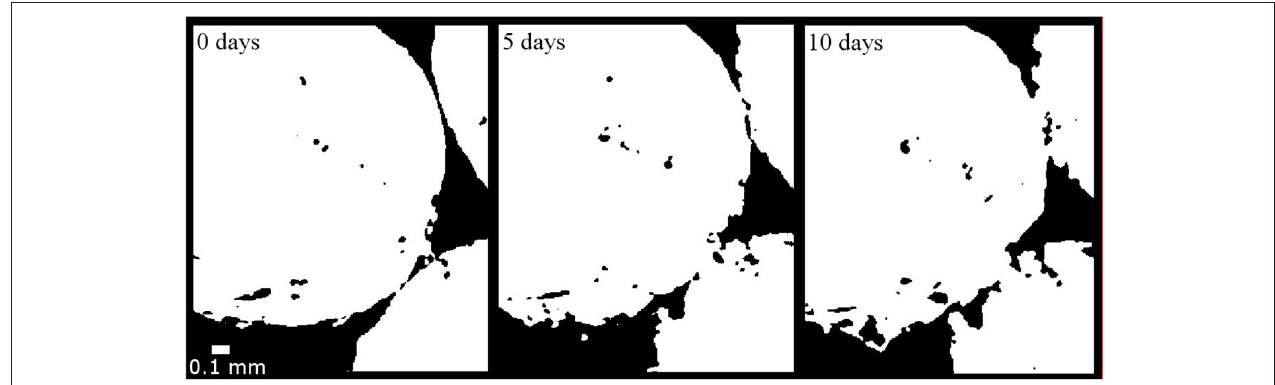
FIGURE 10 | High resolution (6 µ m) CT scans of ice beads, after 0, 5, and 10 days sintering. The 2D cross-sections of the binary images show porous bonds between the particles and their evolution.